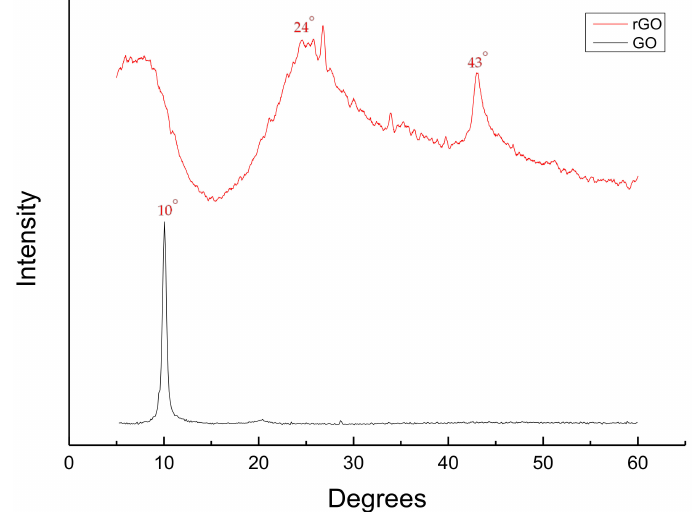
Figure 1. X-ray diffraction pattern of graphene oxide (GO) and reduced graphene oxide